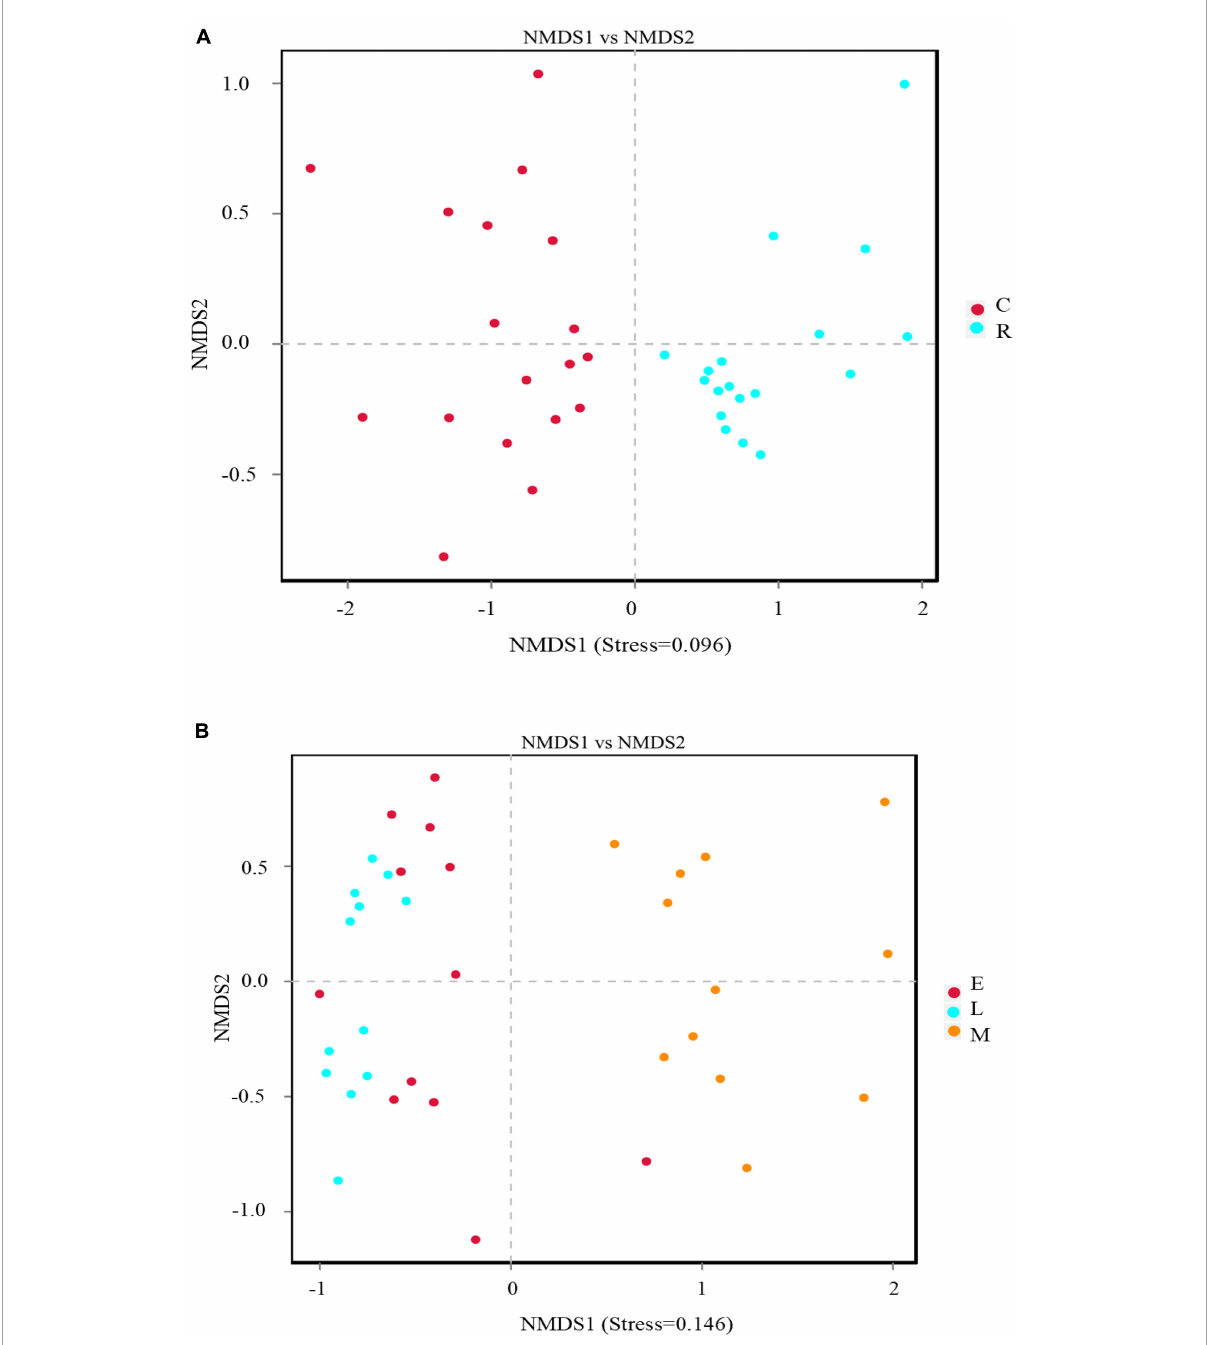
FIGURE3 Non-metric multidimensional scaling (NMDS) analysis based on binary_jaccard method of rhizosphere soil bacterial community composition grouped according to cropping method (A) and growth stage (B) .